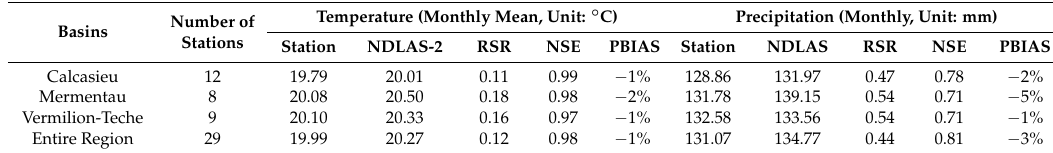
Table 2. Comparison between weather station and North American Land Data Assimilation System (NLDAS-2) data over